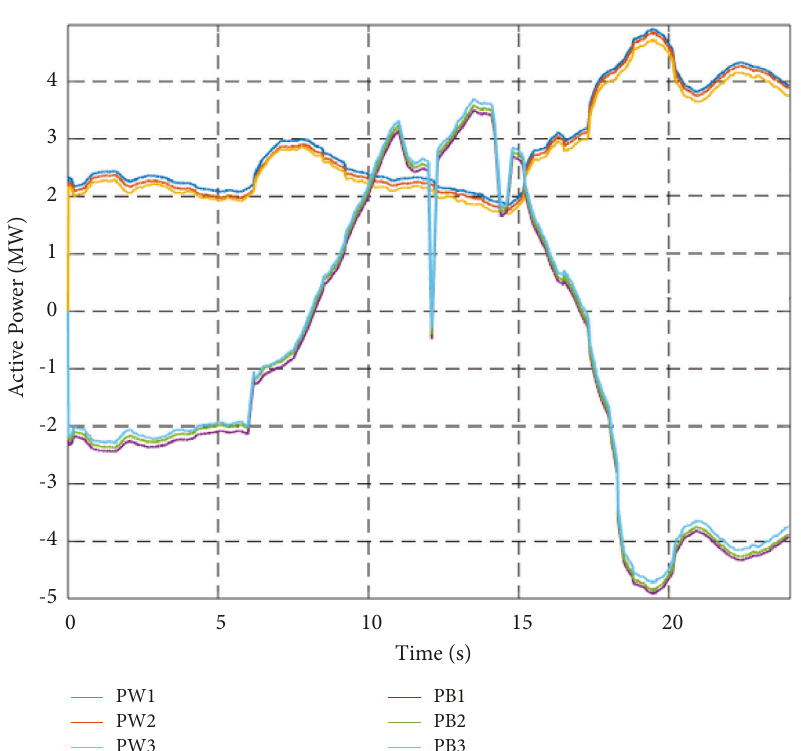
Figure 19: Standalone power for each